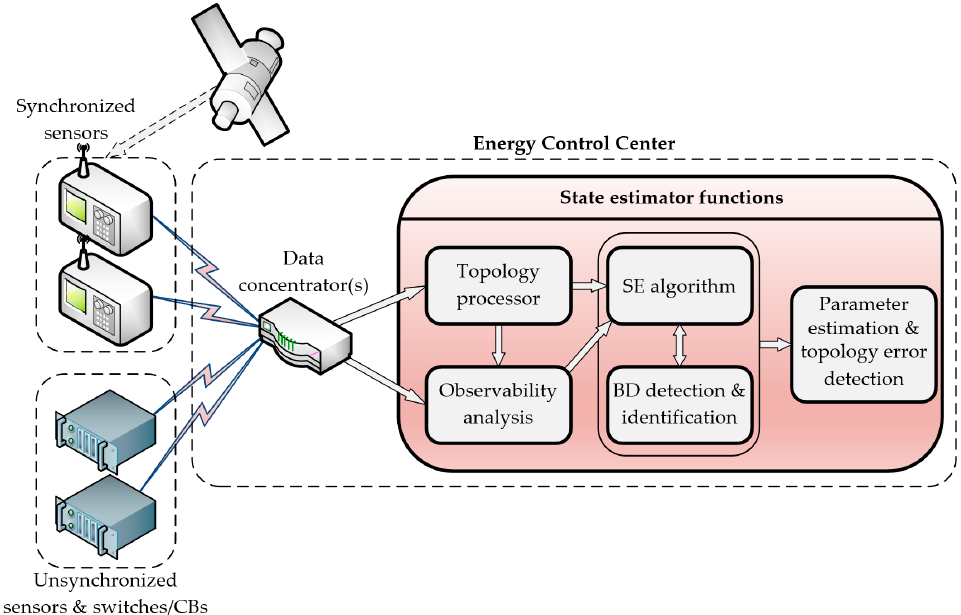
Figure 1. Data flow diagram of SE, from the field sensors to the ECC.